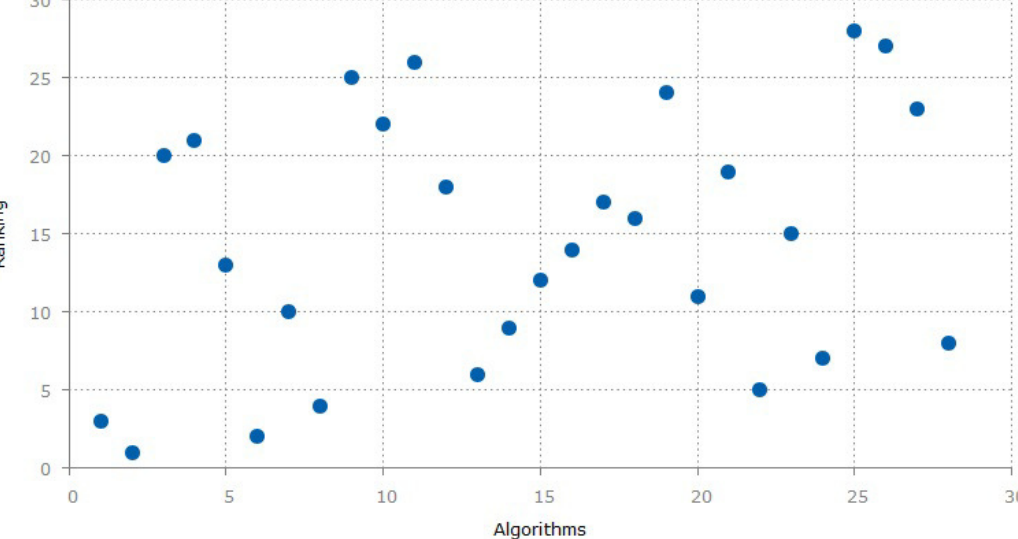
Figure 1. Ranks of Public and Propriety datasets. The algorithms on the x -axis show the ranking that were used by the papers. Each point on the x -axis depicts a study from Table